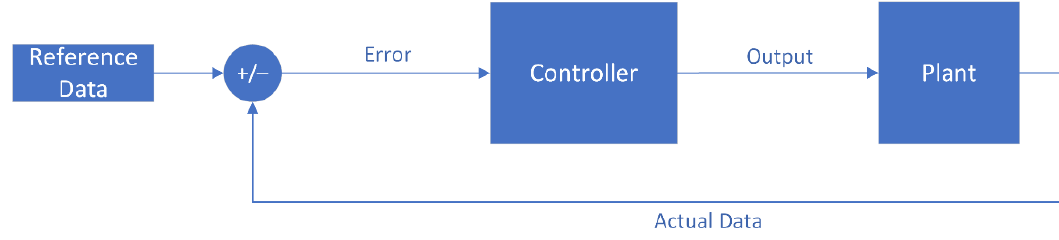
Figure 4. Basic PID control structure.